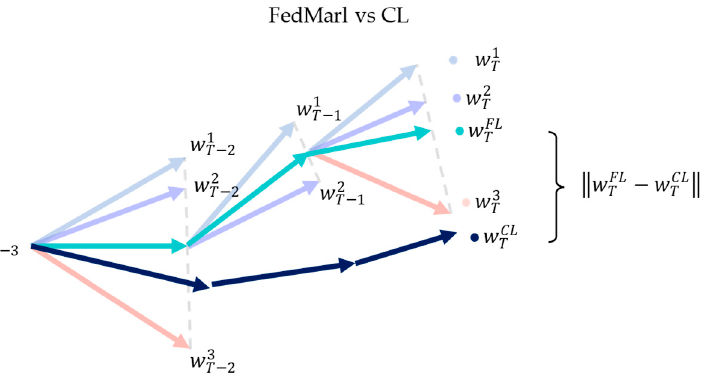
Figure 3. Ineffective client dropping by FedMarl will lead to large weight divergence. Client 3 (denoted by peach) is dropped from training at communication round T − 2. This causes the aggregated FL weights w FL (denoted by green) to converge toward Client 1 and 2 while diverging t away from the w CL t